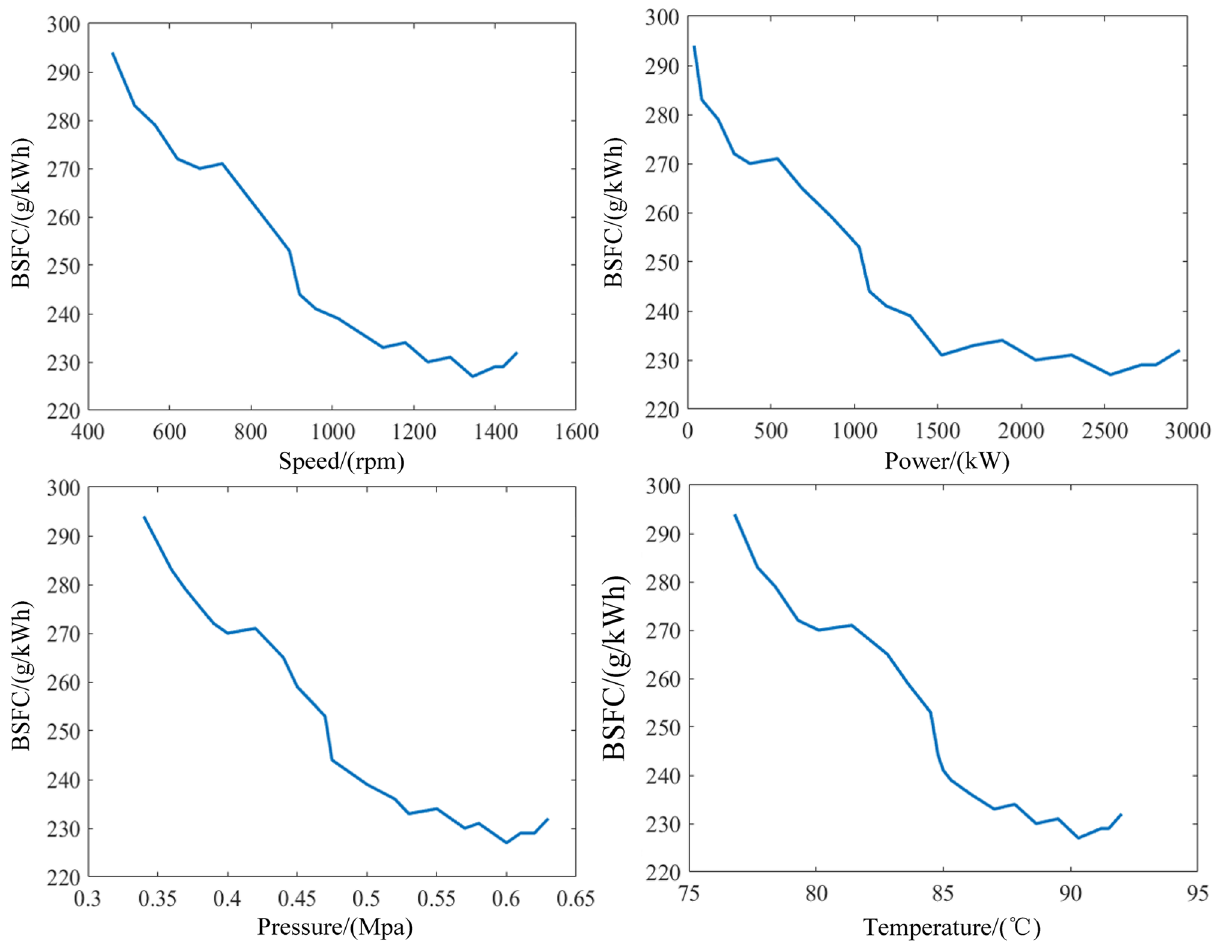
Figure 13. Influence of input parameters on brake specific fuel